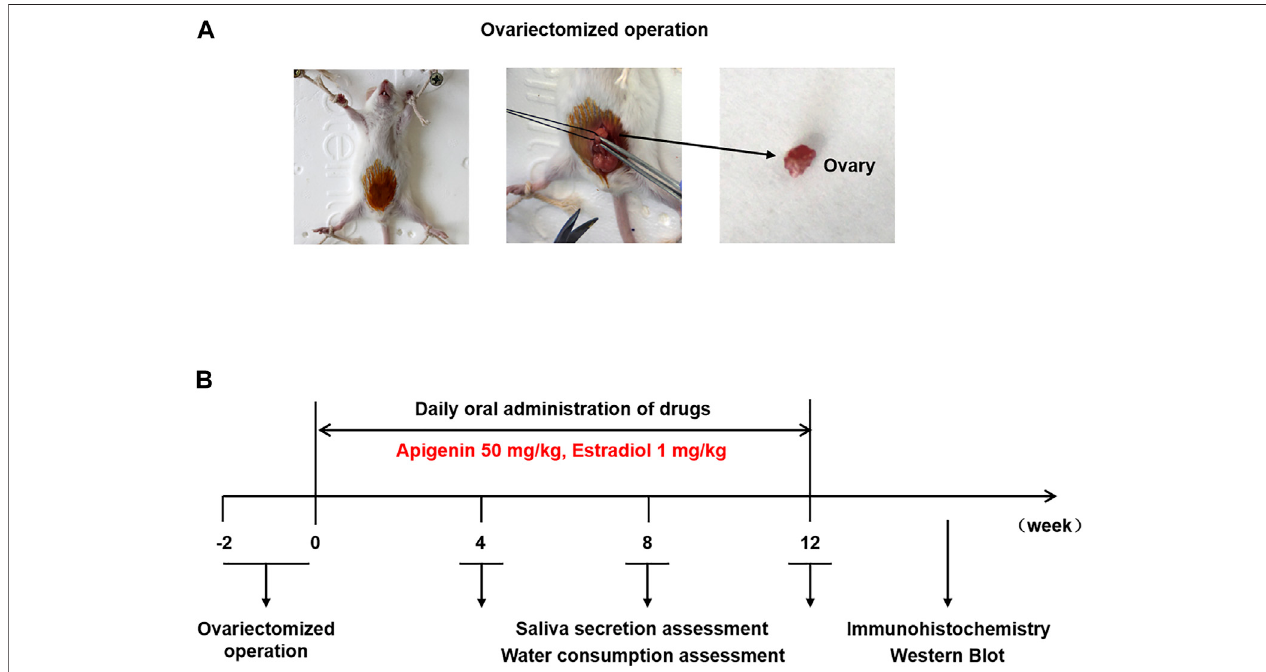
FIGURE 5 | (A) Ovariectomized operation. (B) Scheme of animal experiment and treatment.